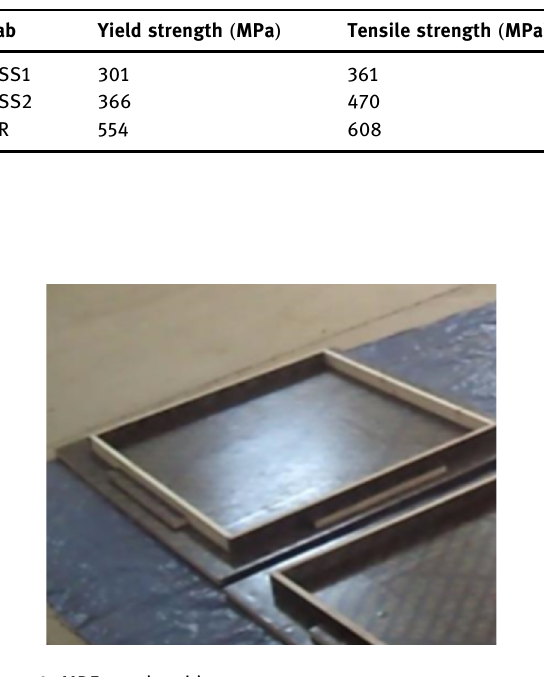
Figure 4: MDF wood molds.